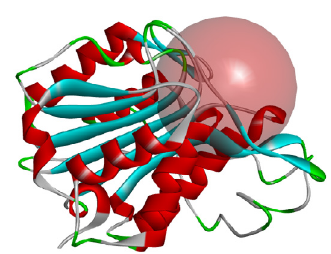
Fig. 1A. 3D Structure of LGMN (PDB ID: 4AWA) Fig. 1B. 3D Structure of prepared LGMN with active sphere shown (PDB ID: